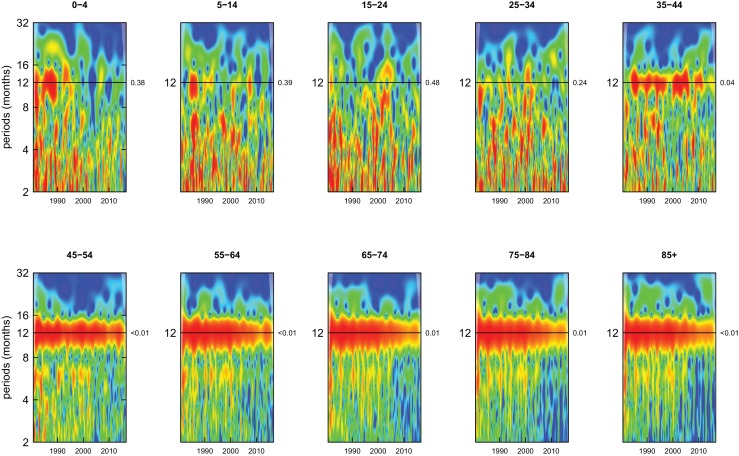
Wavelet power spectra for national time series of cardiovascular disease death rates for 1980–2016, by age group for females.Wavelet power values increase from blue to red. The shaded regions at the left and right edge of each box indicate the cone of influence, where spectral analysis is less robust. P-values for the presence of 12 month seasonality are to the right of each figure at the 12 month line.